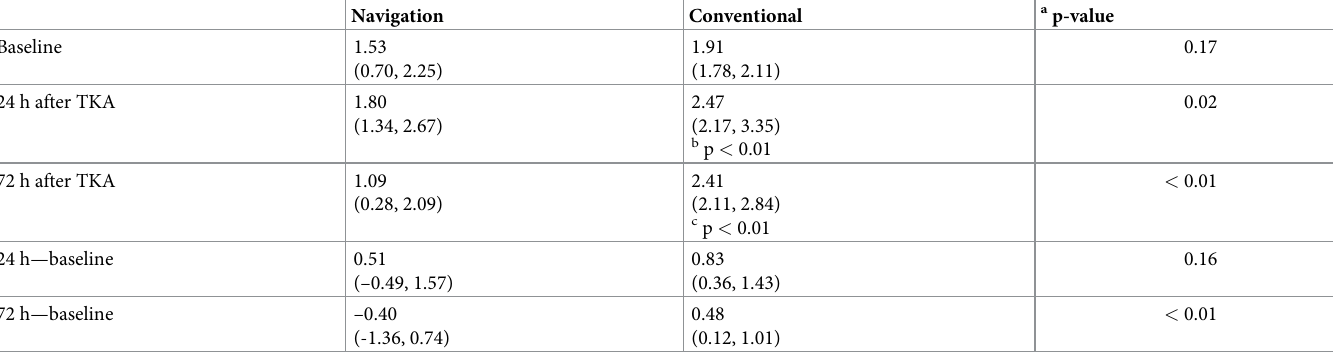
Table 3. Serum IL-10 concentrations (pg/mL) prior to TKA,then at 24 and 72 hours after TKA.